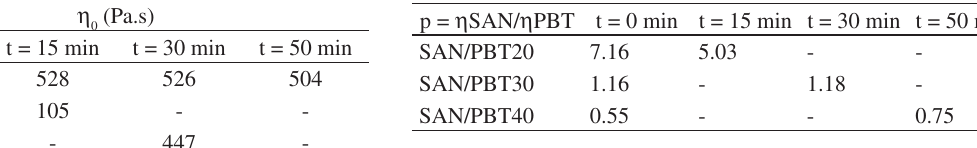
Table 2. Zero shear viscosity, η 240 °C for different times.